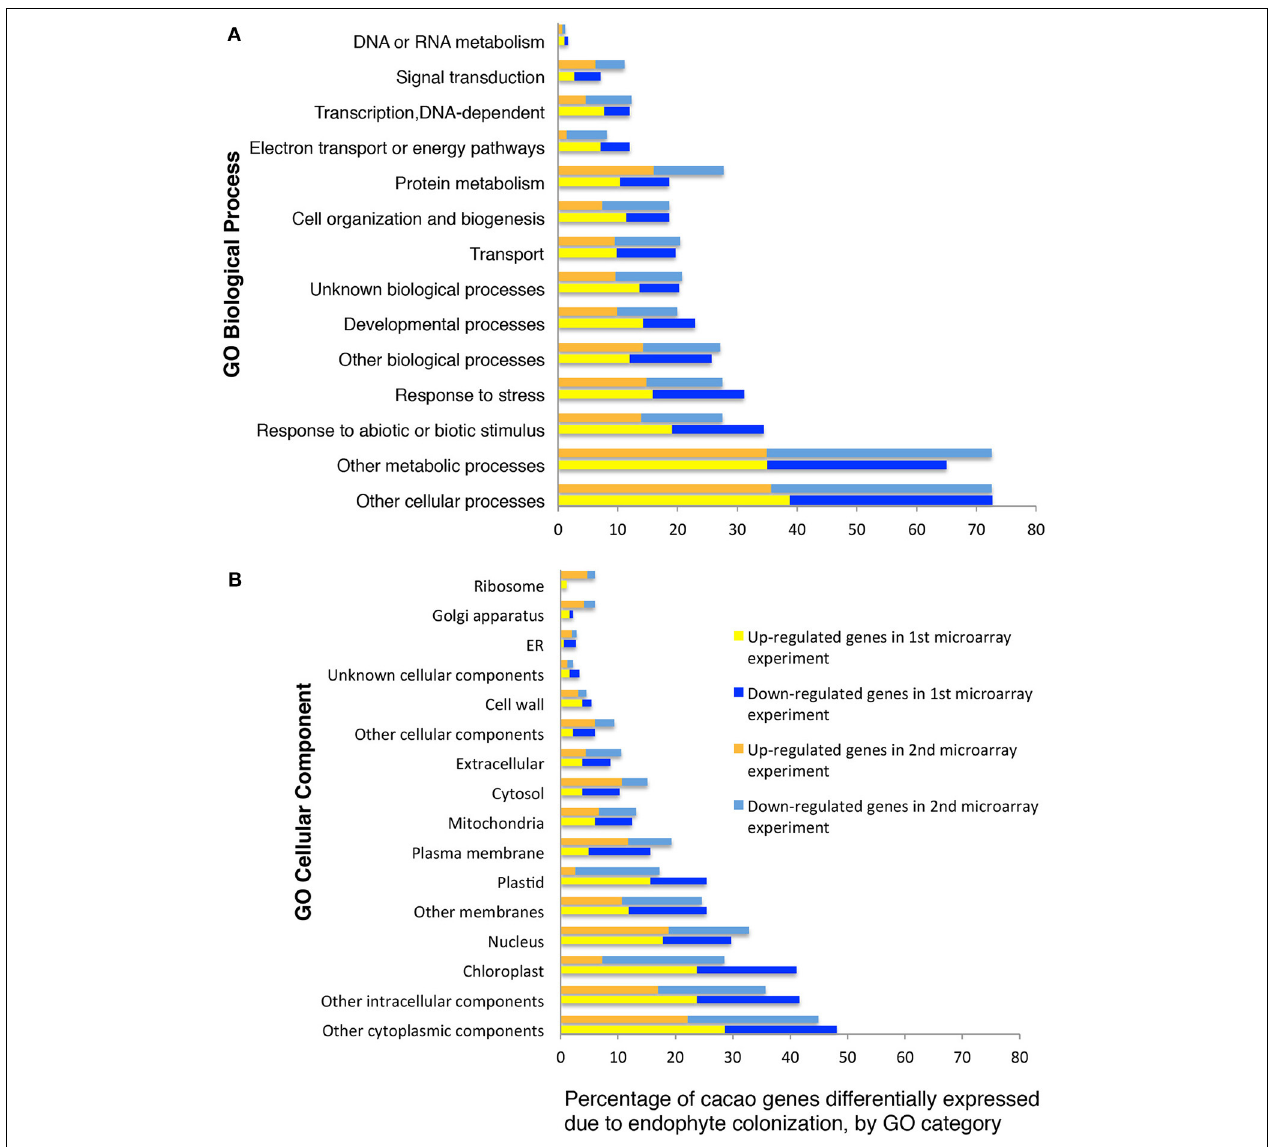
FIGURE 1 | Functional GO categorization of T. cacao genes with significant differences in expression due to endophyte C. tropicale inoculation. Data represent the percentages of genes regulated by endophyte inoculation in different GO categories (i.e., 100 times the number of genes in each GO category divided by the total number of genes